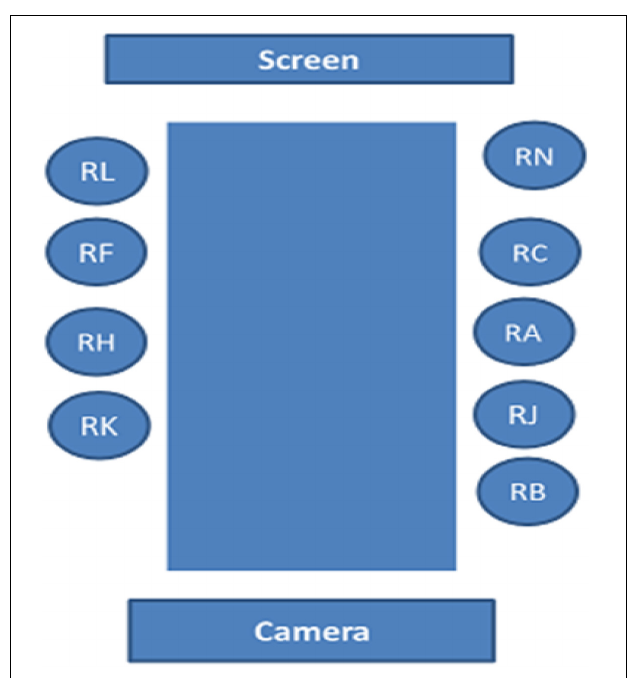
FIGURE 1 | The room layout.